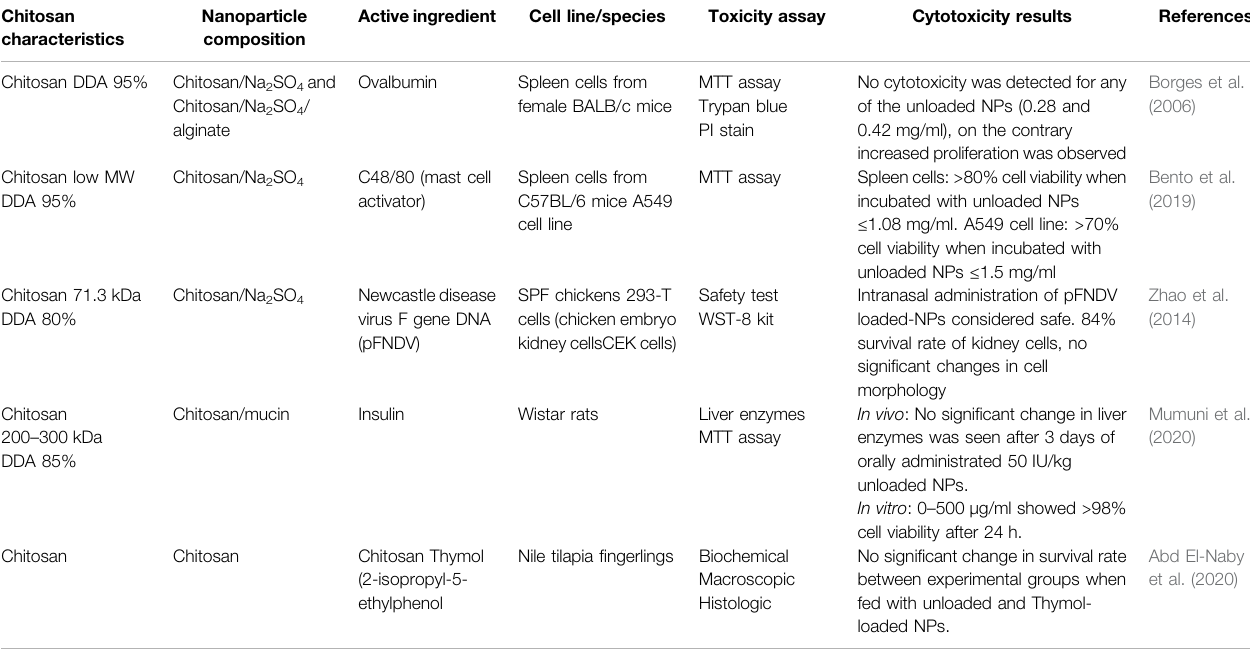
TABLE 2 | Articles on chitosan nanoparticles without TPP as crosslinker, main fi ndings. Chitosan